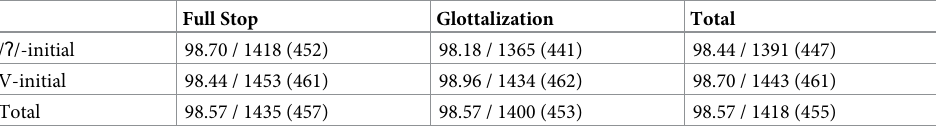
Table 1. Mean accuracy in % and reaction time in ms (SD for single trials in brackets) for Experiment